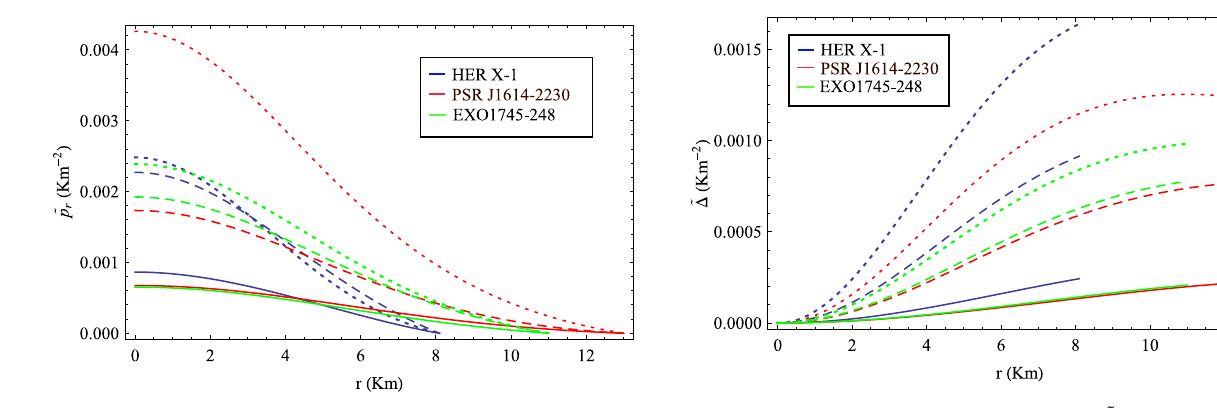
Fig. 5 Radial variation of anisotropic pressure ( ˜ Δ ) for different com- pact objects as indicated in the figure. Here plots with solid, dashed and dotted lines correspond to D = 4 , 5 and 6 respectively. To obtain the plots we choose (i) α = 0 . 4, γ = 0 . 45 when D = 4; α = 0 . 3, γ = 0 . 25 when D = 5 and α = 0 . 25, γ = 0 . 2 when D = 6 for HER X-1, (ii) α = 0 . 4, γ = 0 . 5 when D = 4; α = 0 . 3, γ = 0 . 25 when D = 5 and α = 0 . 2, γ = 0 . 15 when D = 6 for PSR J1614-2230, (iii) α = 0 . 4, γ = 0 . 5 when D = 4; α = 0 . 3, γ = 0 . 2 when D = 5 and α = 0 . 2, γ